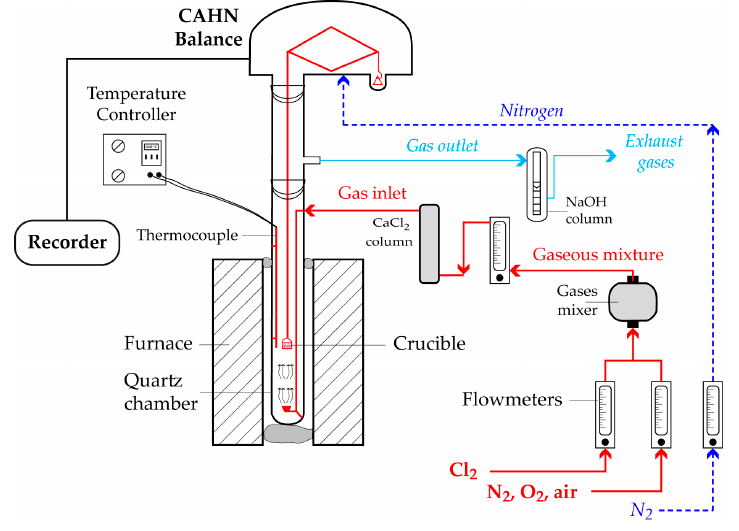
Figure 2. Setup of the TG analysis experiment.